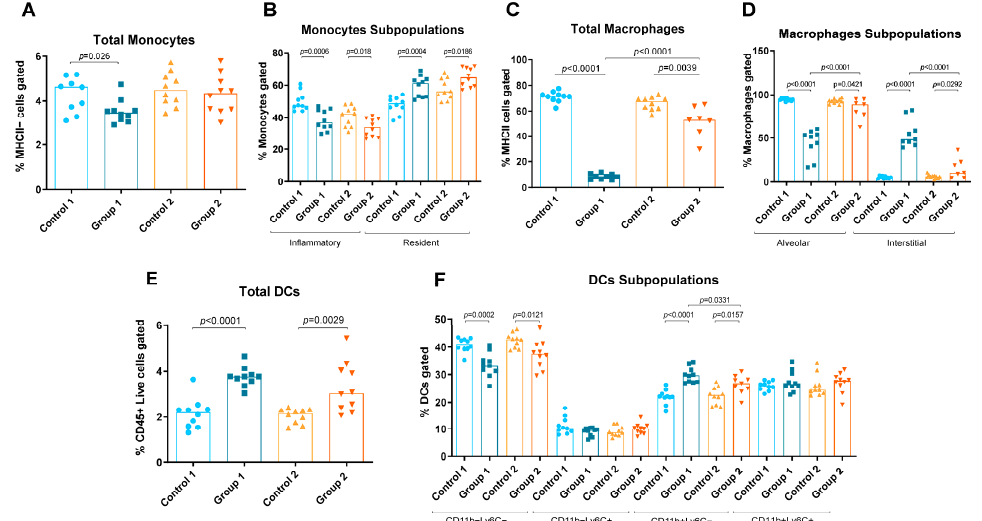
Figure 3. Monocyte, macrophage and dendritic cell (DC) levels in lung homogenates from flow cytometry analysis. Experimental groups are the same as in Figure in Section 4.3. In each group, data are shown as individual and median values of total monocytes ( A ), inflammatory and resident monocytes ( B ), total macrophages ( C ), alveolar and interstitial macrophages ( D ), total DCs ( E ), and CD11b − Ly6C − , CD11b − Ly6C+, CD11b+Ly6C − and CD11b+Ly6C+ DCs ( F